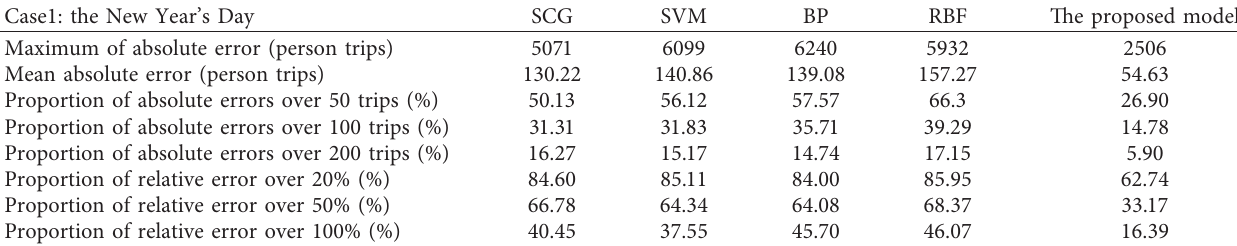
Table 6: Statistics of model deviation in the New Year’s Day.